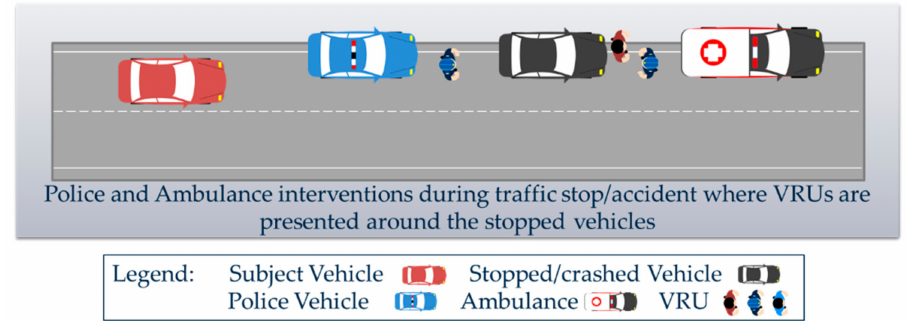
Figure 5. Occupants alighted from a police car or ambulance may stand near or move around the vehicles during a police traffic stop or crash involving injured